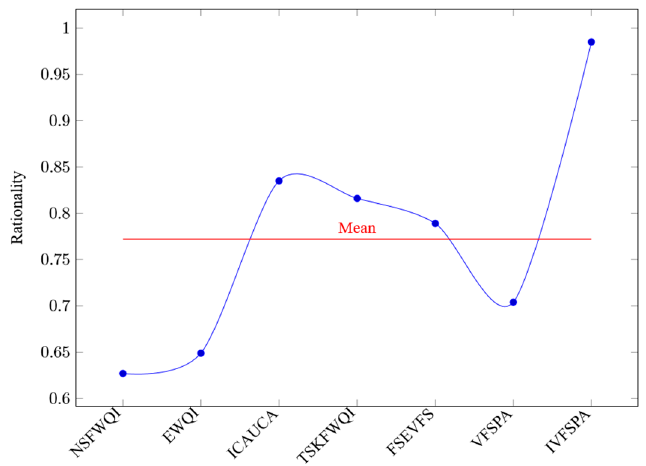
Figure 8. Rationality values.